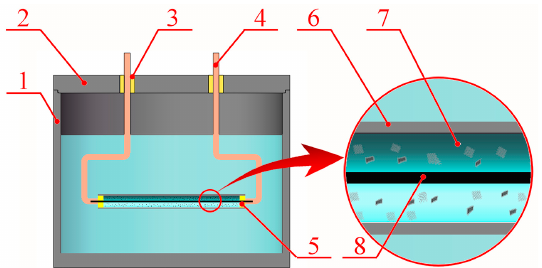
Figure 1. An illustration of the pulsed iron wire discharge setup. 1—stainless steel chamber, 2—lid, 3—nsulation pipe, 4—electrodes, 5—insulation block, 6—plastic pipe, 7—graphene oxide (GO) suspension and 8—iron wire.